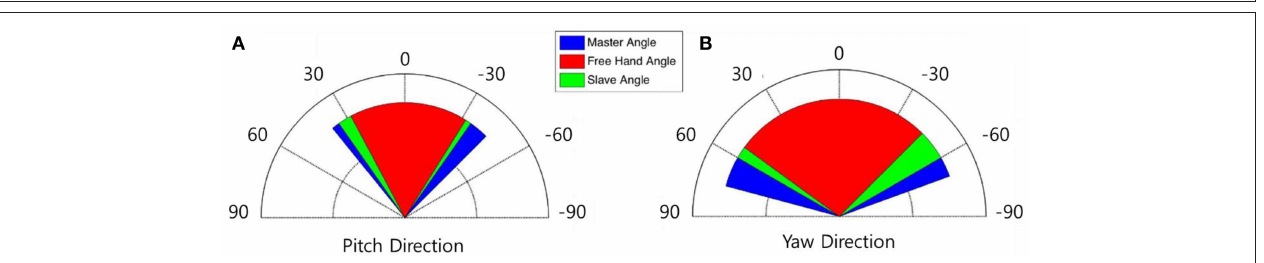
FIGURE 7 | Schematic diagram of the proposed master-slave haptic system.